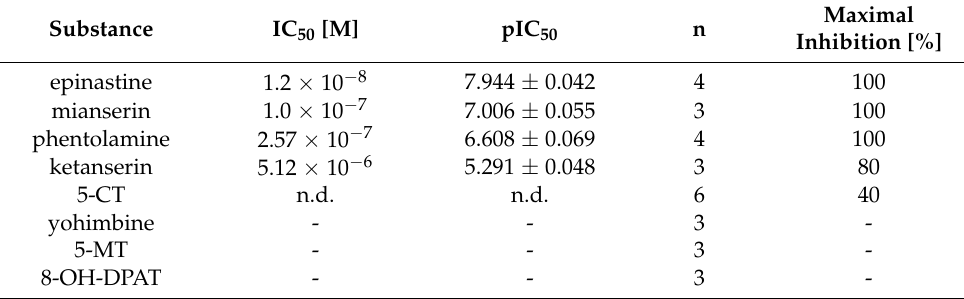
Figure 7. Effects of putative antagonists on octopamine-activated PaOct β 2R-HA. Concentration series of ( A ) epinastine, ( B ) mianserin, ( C ) phentolamine, and ( D ) ketanserin were applied in the presence of 1 × 10 − 9 M octopamine and 1 × 10 − 4 M IBMX. Relative change in fluorescence (corresponding to the amount of cAMP) is given as the percentage of the value obtained in the exclusive presence of 1 × 10 − 9 M octopamine (=100%). Data represent the mean ± SD of eight values from a typical experiment. All determinations were independently repeated at least three times. Table 2. Mean values for half-maximal inhibition (IC 50 [M] and pIC 50 ± SD) for substances with antagonistic activity on octopamine-activated PaOct β 2R-HA. For each substance, at least three independent experiments (n) with octuplicate measurements were performed. Values were obtained from non-linear fitting of the data from concentration-response curves (GraphPad Prism 5.04). The maximal inhibition of PaOct β 2R-HA activity is given in